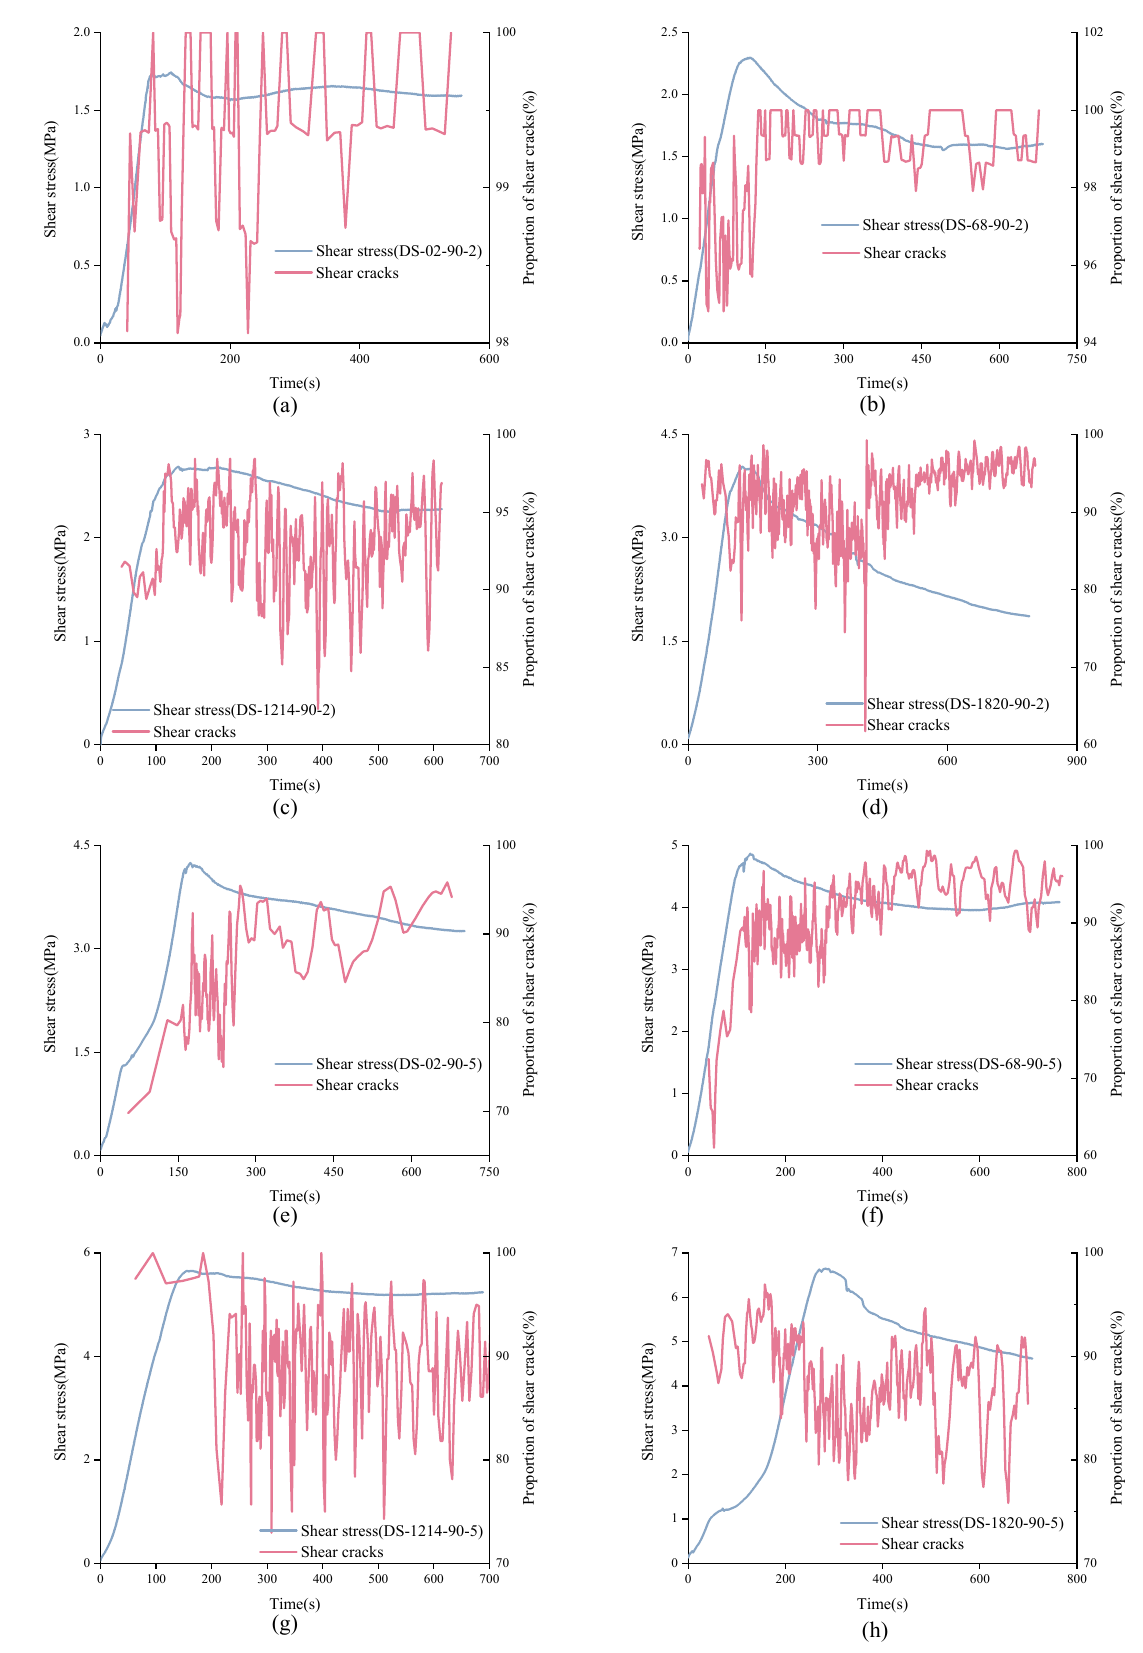
Figure 19. Variation trend of real-time shear cracks’ proportion curves of anchored structural planes with anchorage angle of 90°. ( a ) DS-02-90-2 ( b ) DS-68-90-2 ( c ) DS-1214-90-2 ( d ) DS-1618-90-2 ( e ) DS-02-90-5 ( f ) DS-68-90-5 ( g ) DS-1214-90-5 ( h ) DS-1820-90-5.